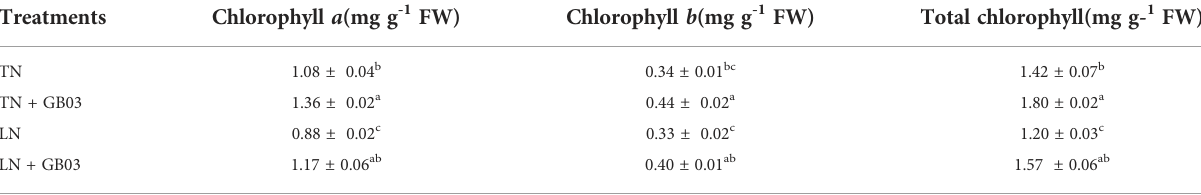
TABLE 1 The chlorophyll a , b and total chlorophyll concentrations in tall